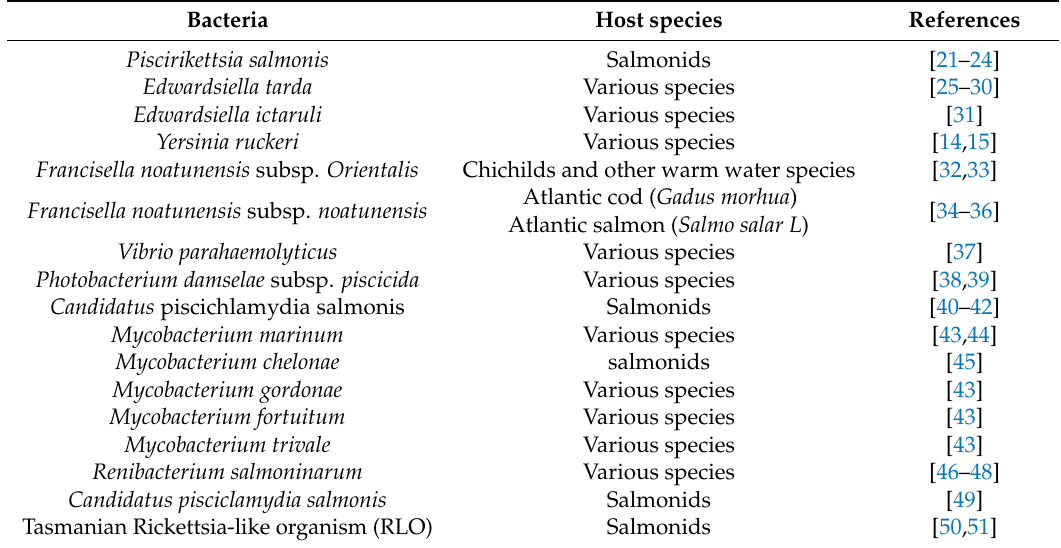
Table 1. Intracellular bacteria species characterized in fish.